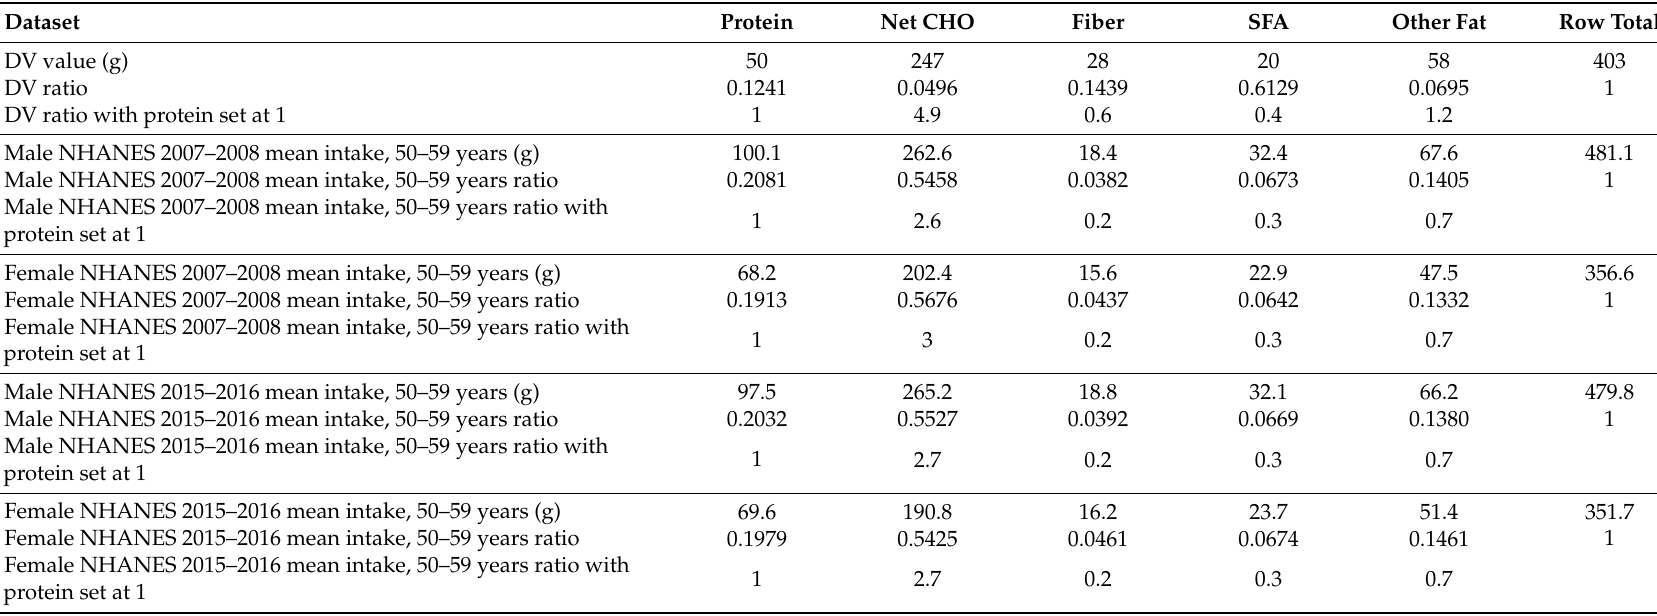
Table 2. The Daily Values (DVs) and food intakes (derived from the National Health and Nutrition Examination Survey (NHANES) 2007–2008 and 2015–2016 data) for males and females 51–59 years of age, their ratios, and their ratios relative to